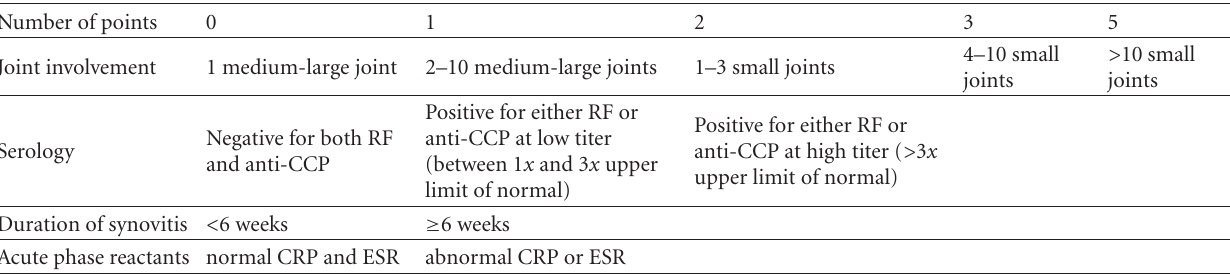
Table 3: 2010 ACR/EULAR scoring criteria for RA. The following table provides the scoring criteria for di ff erent domains of evaluation. For each cell in the table for which the patient satisfies the condition, the cell is scored by the number of points at the top of the column in which it is found. The patient’s score is the sum of the scores for the individual cells. Patients with a total score of 6 or more points are diagnosed as having